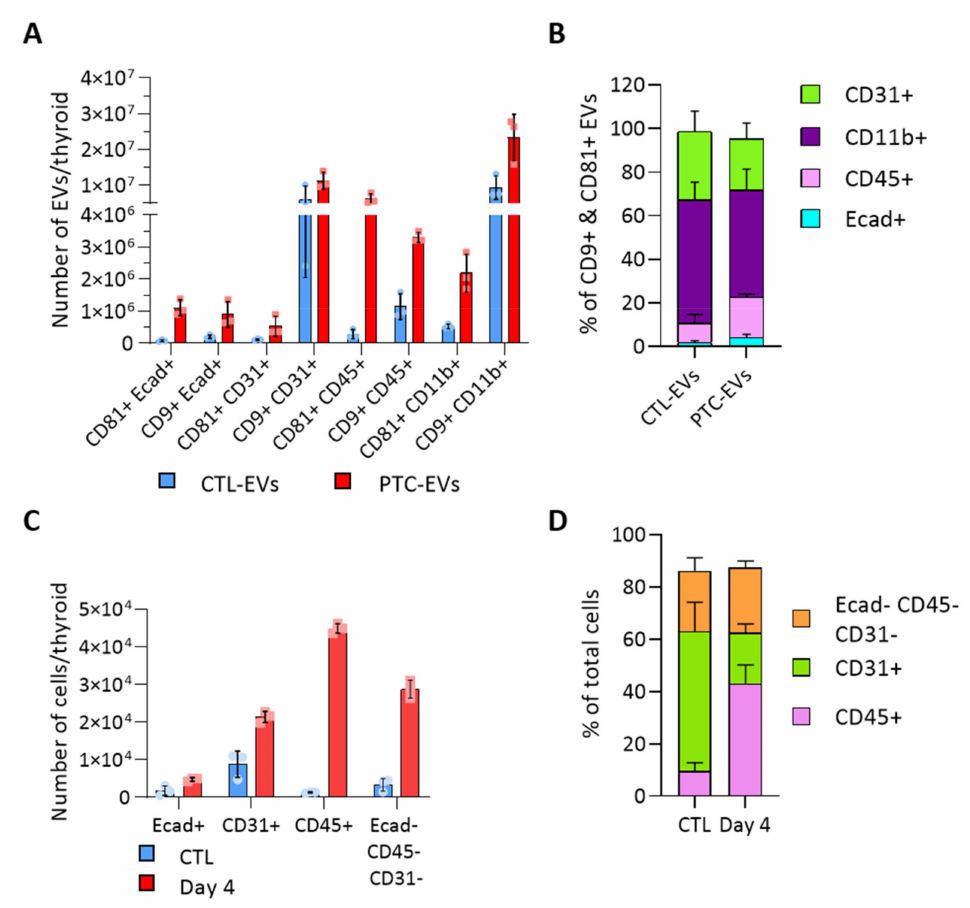
Figure 3. BRAF V600E -driven tissue transformation alters the proportion of cellular and EV popu- lations. ( A , B ) Results obtained with the ExoView platform (n = 3). Capture antibodies were directed against CD9 and CD81 tetraspanins. Two detection panels were used with antibodies directed against Ecad and CD31 or CD45 and CD11b: ( A ) number of EVs in the control and PTC samples (day 4) ac- cording to the tetraspanin and the cellular marker present on EVs; and ( B ) percentage of EVs bearing each population marker (Ecad, CD31, CD45, CD11b) in the two, CD9+ and CD81+, EV populations. ( C , D ) Results obtained by FACS analysis (n = 4). Sorting antibodies were directed against Ecad, CD31 and CD45: ( C ) number of Ecad+, CD31+, CD45+ and triple negative cells in control and DOX-treated dissociated tissues (day 4); and ( D ) percentage of non-epithelial cell populations from dissociated control and DOX-treated tissues (day